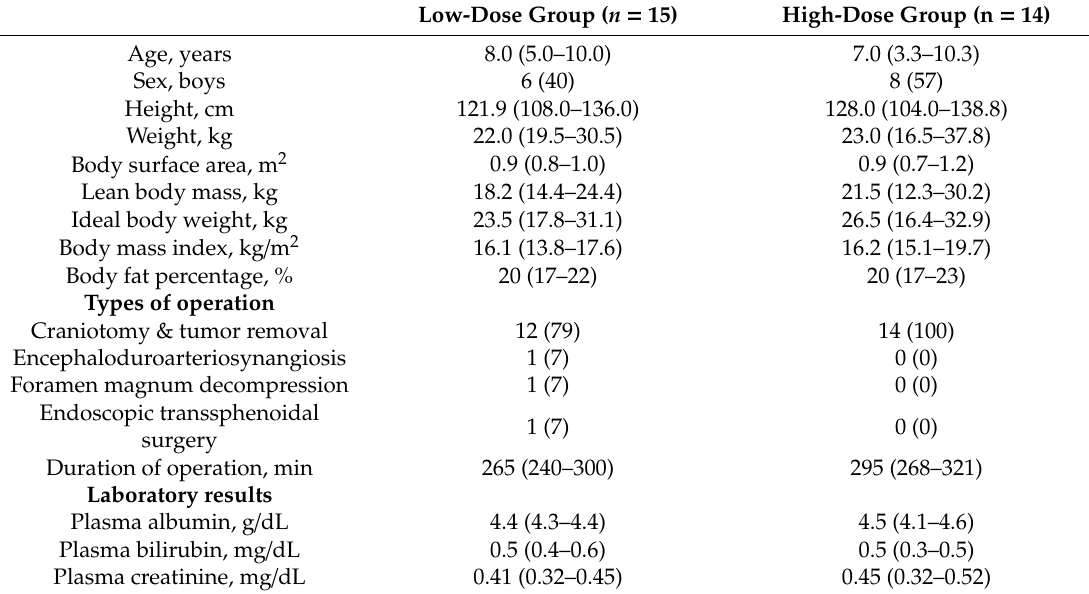
Table 1. Patient characteristics and perioperative variables of the study participants. Values are the median (interquartile range) or number